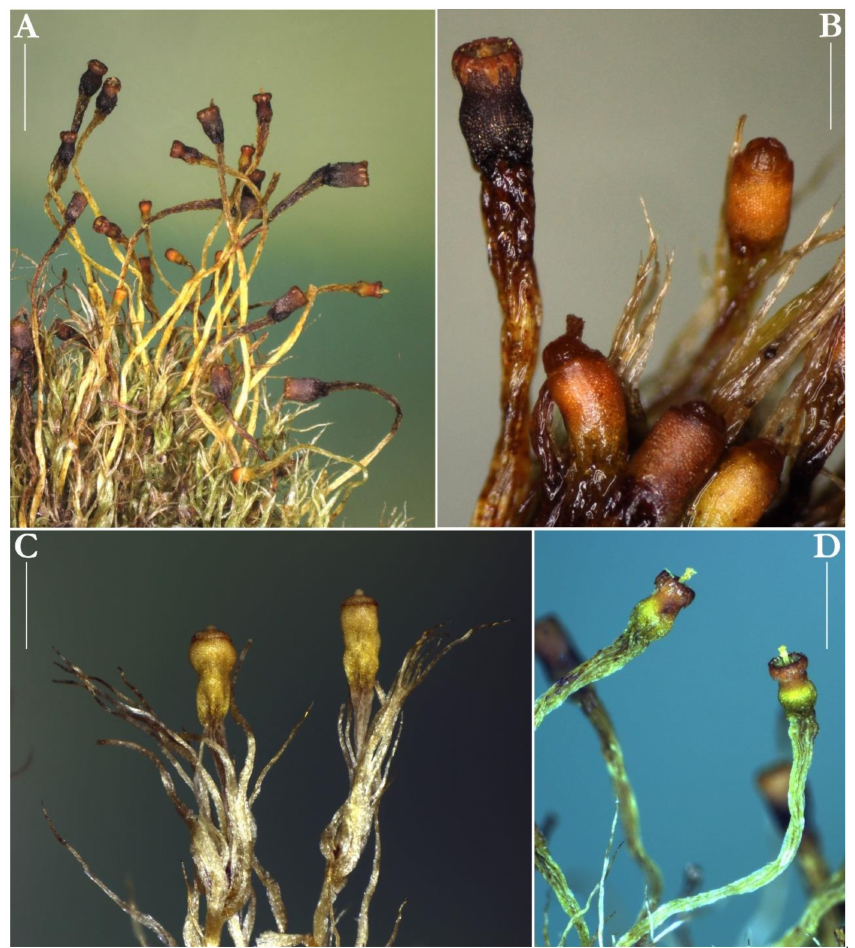
Figure 2. Macro photographs of Splachnum pensylvanicum taken from the specimens from Kamanos mire in Lithuania: ( A ) portion of dry tuft showing the plants with numerous mature sporophytes, ( B ) mature deoperculate capsules, ( C ) mature operculate capsules, ( D ) two deoperculate capsules with expanded columellae. All taken from KRAM B-242426 ( A , B , D ) and KRAM B-242425 ( C ). Scale bars: ( A )—3 mm, ( B )—0.5 mm, ( C , D )—1